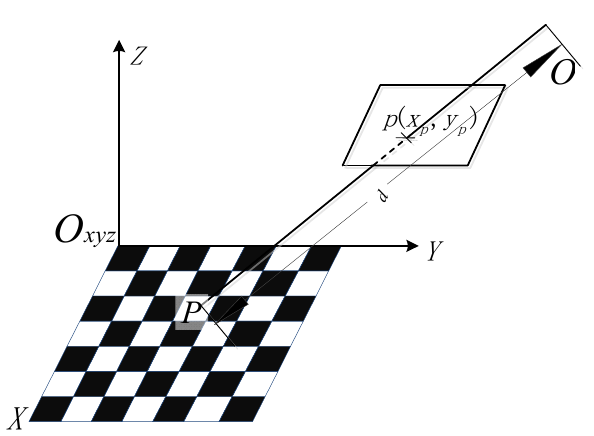
Figure 9. The combined calibration